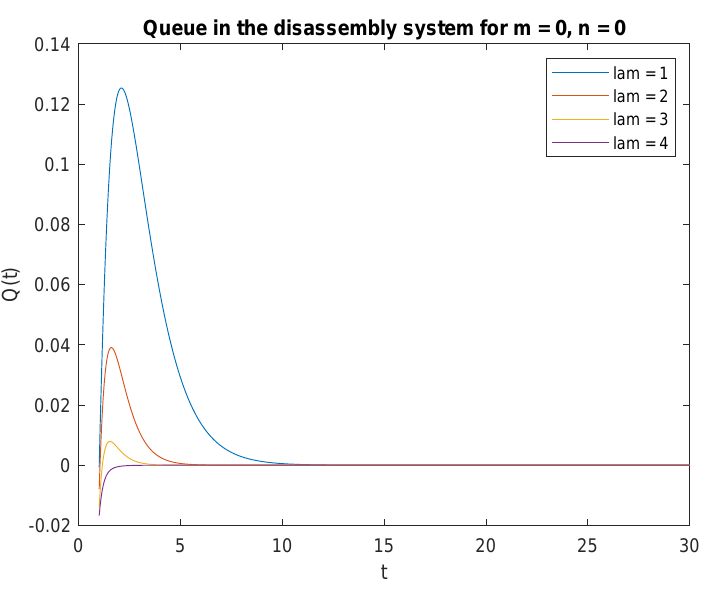
Figure 8. Impact of arrival rate on probability P { X ( t ) = m = 0 | X ( 0 ) = n = 0 } . Observe probabilities P { X ( t ) = 0 | X 0 = 0 } (Figure 8) and P { X ( t ) = 0 | X 0 = 1 } (Figure 9), the transient conditional distributions increase as inter-arrival rates decrease λ = 1, λ = 2, λ = 3, and lambda = 4. The transient conditional distributions increase shortly after the opening of the disassembly system for inter-arrival rates λ = 1, λ = 2, (Figures 8 and 9). The transient conditional distributions decrease constantly after opening the disassembly system for inter-arrival rates λ = 3, λ = 2, starting from the peak at the beginning of the simulation (Figures 8 and 9).